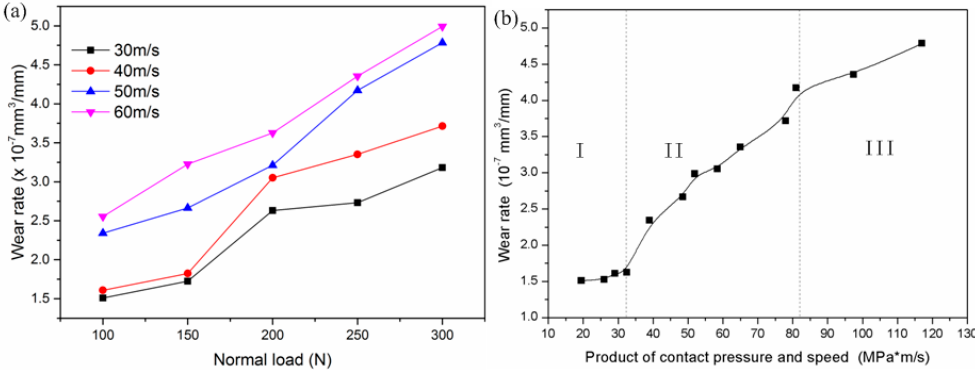
Figure 5. Wear rate: ( a ) at various loads vs. ( b ) the product of contact pressure and speed.